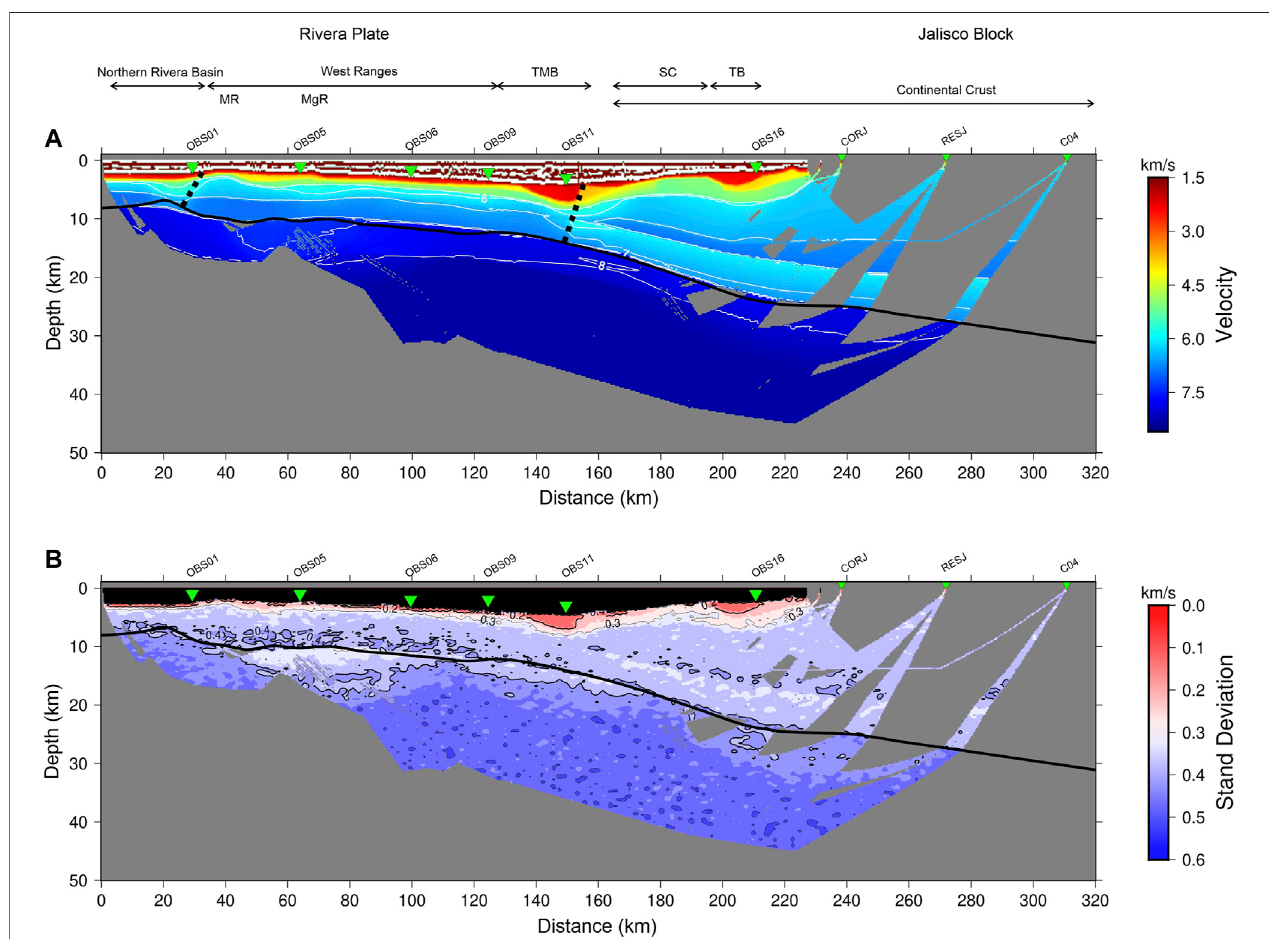
FIGURE8|(A) FinalRTSIM02seismicvelocitymodelafterinvertingwide-anglerefractionsandre fl ectionswithTOMO2D.Theblackthicklineshowsthelocationof the Moho re fl ector and oblique dash black lines denote the region interpreted as extended and thinned continental crust. (B) Final standard deviation values for the P-wave velocity values resulted from the statistical uncertainty